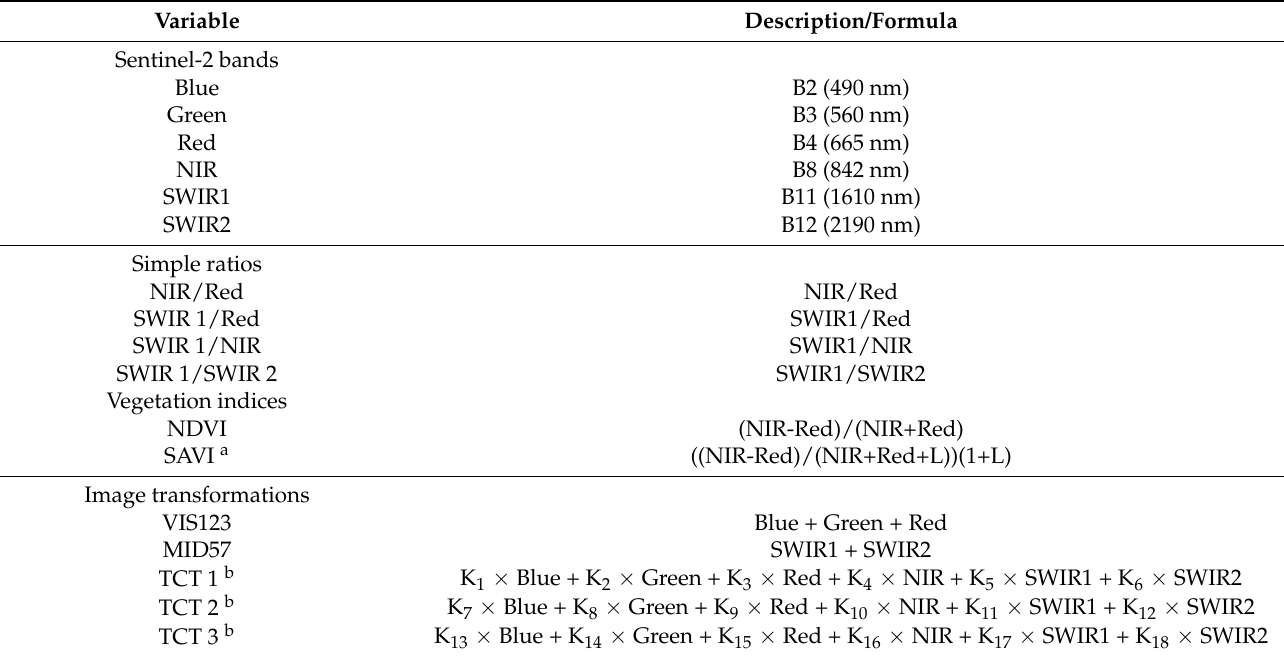
Figure A1. Estimated beta coefficients for mean detection estimation in the study landscape (Posterior means with 95% and 50% Bayesian credible intervals). Black bars indicate that the 95% CI does not overlap zero, and gray bars with closed circles indicate that the 50% CI does not overlap zero, but the 95% CI and gray bars with open circles indicate that the 50% CI overlap zero. Table A1. Sentinel-2 predictors used in the Random Forest (RF) classification